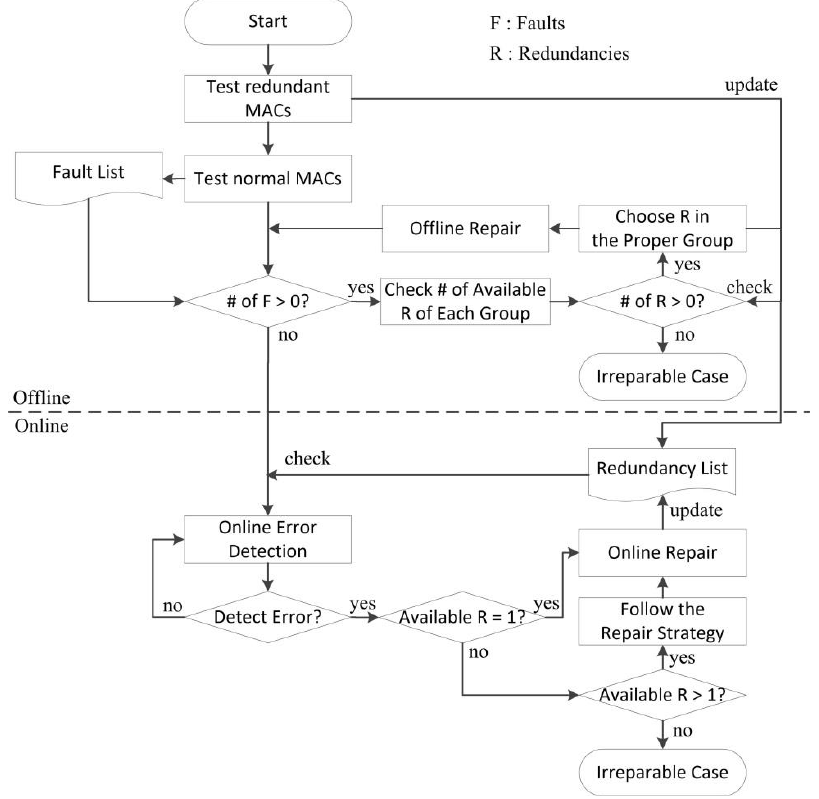
Figure 6. Flowchart of the proposed method.